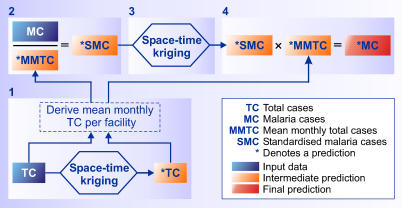
Schematic Diagram of the Modelling FrameworkFour stages were used to predict the count of outpatients treated for malaria (MC) for each facility-month with missing data: (1) MMTC was estimated for each facility using both existing and predicted values of TC; (2) existing MC data at each facility were standardised by the corresponding MMTC value to create SMC values; (3) STK was used to predict all missing values of SMC; and (4) MMTC values were used to back-transform the predicted SMC values in order to obtain final predictions of MC.